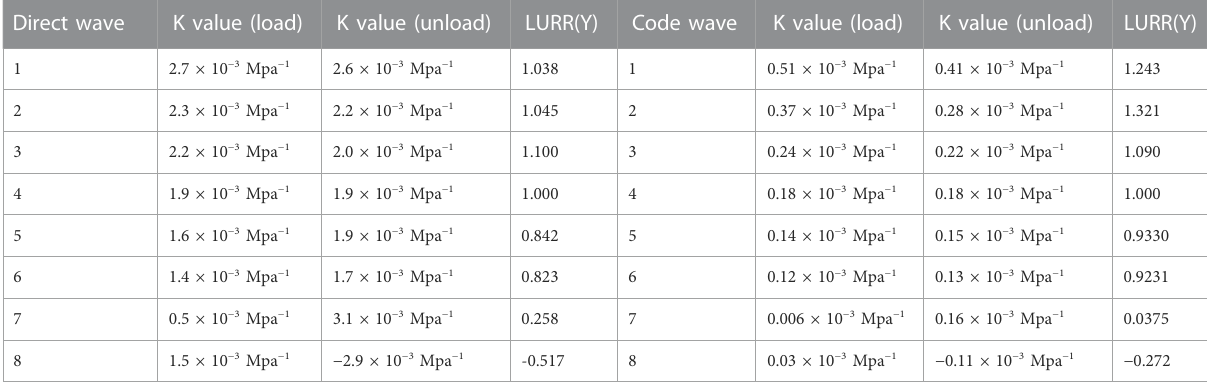
TABLE 1 Parameter changes at different stages. Direct